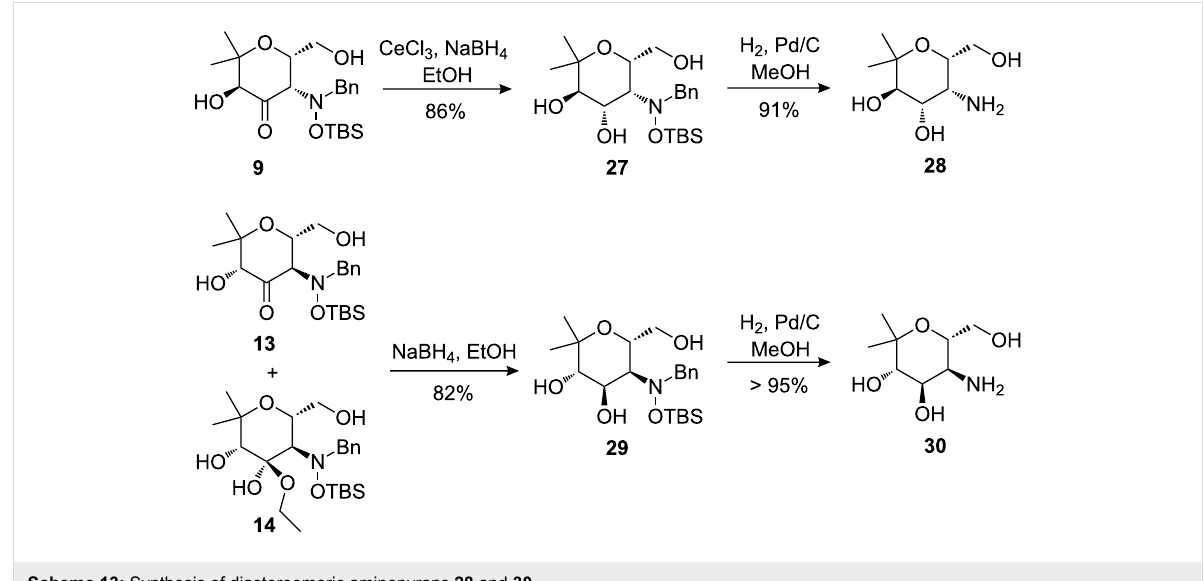
Scheme 13: Synthesis of diastereomeric aminopyrans 28 and 30